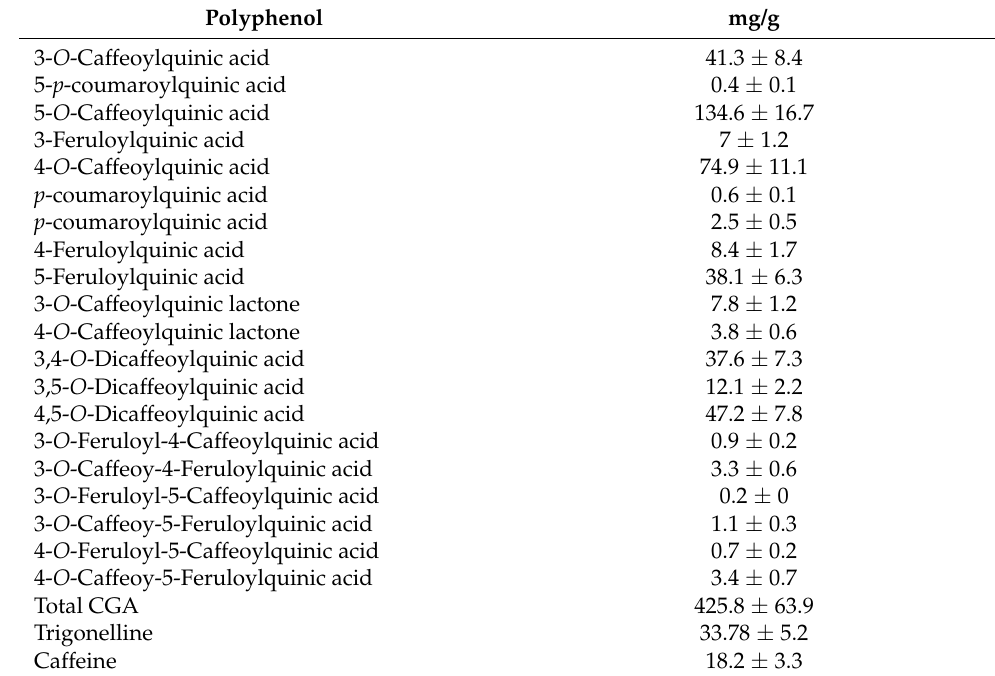
Table 1. List of polyphenol compounds in WCCE, expressed in mg/g ± SD. Table adapted from the work of Nemzer et al. (under review)